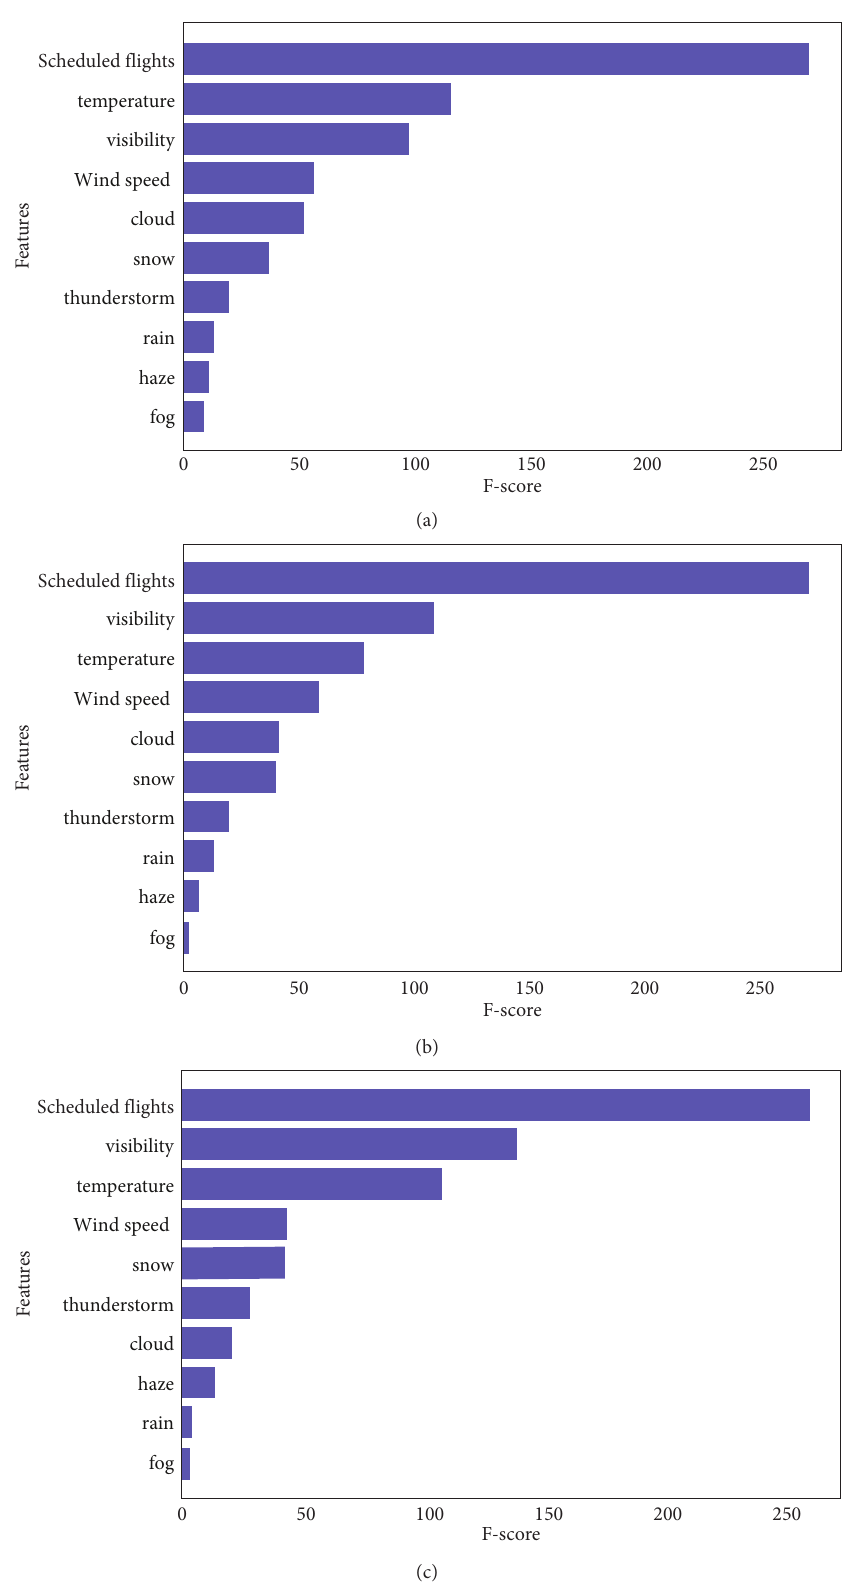
Figure 6: Relative feature importance for 120 min arrival flow prediction. (a) 30 min arrival flow prediction. (b) 60 min arrival flow prediction. (c) 120 min arrival flow